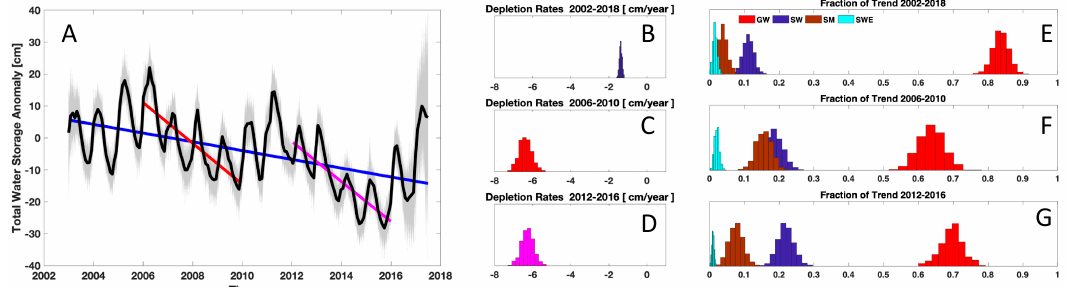
Figure 4. ( A ) Temporal dynamics of TWS from GRACE. The blue line represents the trend of TWS for the entire time period, and the red and magenta lines represent the trend during drought periods. ( B–D ) Histograms showing the magnitude and its uncertainty of the trends in TWS depicted in Panel A for all of the ensemble simulations. ( E–G ) Disentangling the trends in TWS shows that the majority of the losses are due to changes in groundwater storage (red), compared to losses in surface storage (blue), soil moisture (brown), or snow pack (light blue).